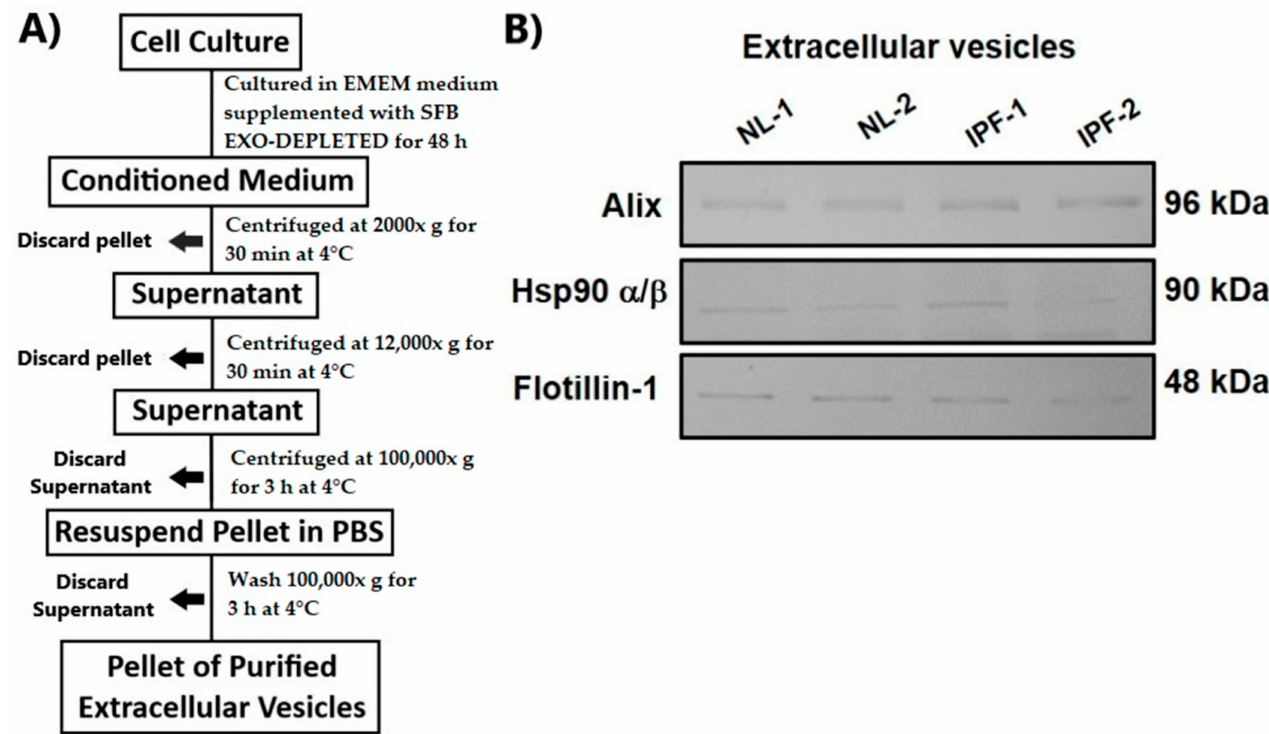
Figure 1. Isolation and characterization of EVs. ( A ) EVs isolation protocol. ( B ) Western blot analysis of EVs markers Alix (96 kDa), Hsp90 α / β (90 kDa), and Flotilin-1 (48 kDa). IPF, idiopathic pulmonary fibrosis; NL, normal